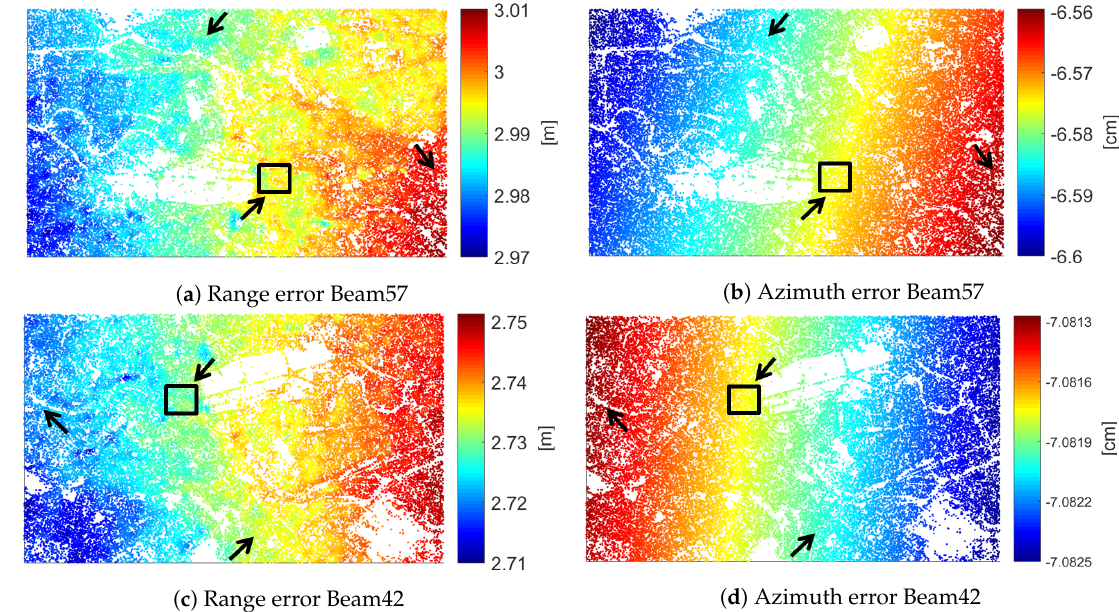
Figure 9. Range and azimuth error in the radar coordinate system ( x -axis: range, y -axis: azimuth) of the master scenes of both investigated beams, which were acquired on 24 December 2011 (Beam57) and on 7 March 2012 (Beam42). Note that the scale of the colorbars for range error is in meters while the one for azimuth errors is in centimeters. The test sites used for vertical and horizontal accuracy analysis are marked with black rectangle and black arrows,